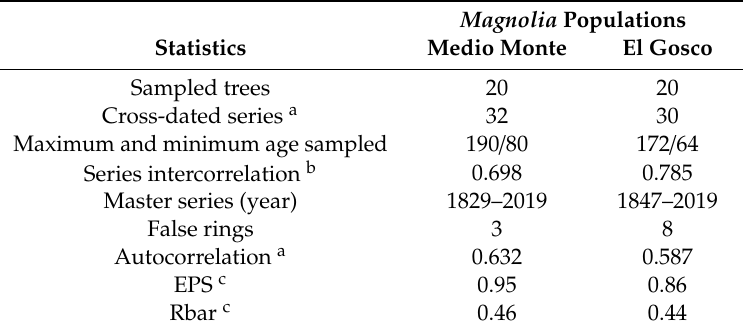
Table 3. Tree-ring characteristics for two Magnolia schiedeana populations.